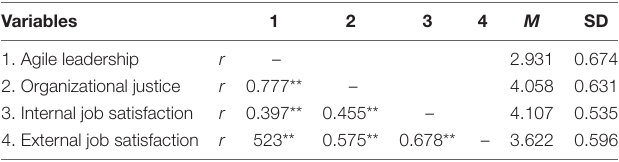
TABLE 2 | The relationship between agile leadership, job satisfaction, and organizational justice.